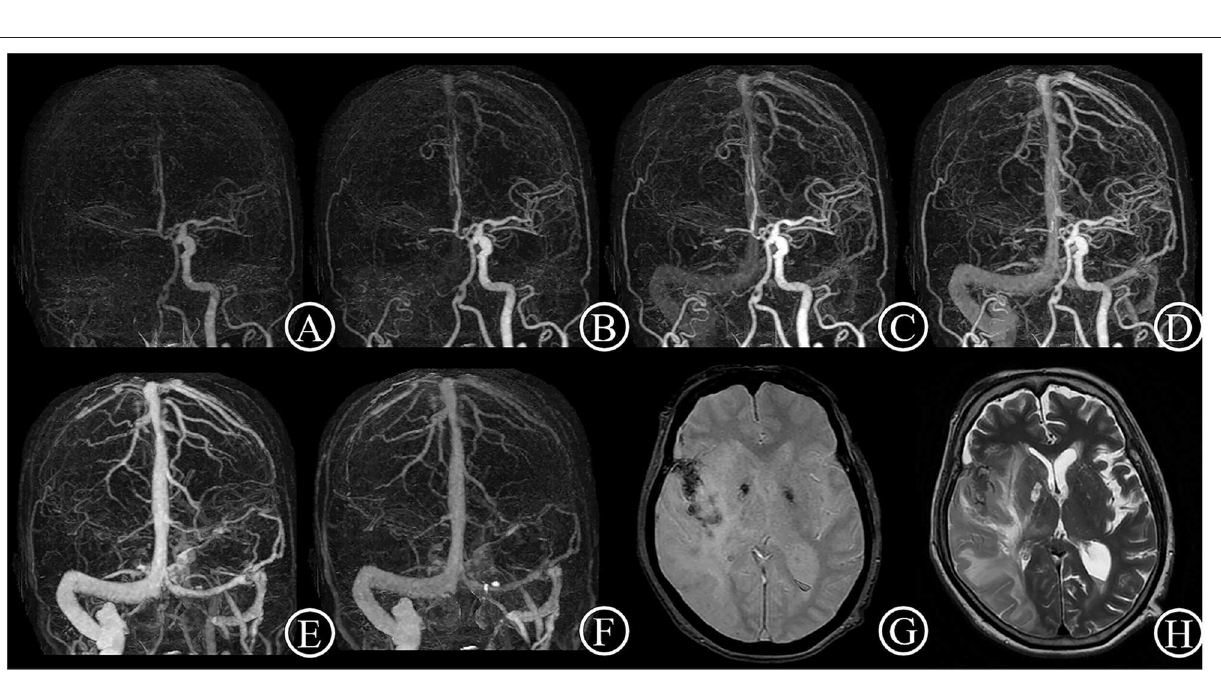
may play a role in the pathogenesis of HT (23). In addition, the following reactions occur after reperfusion: endothelial cell adhesion molecule expression, excitatory amino acid